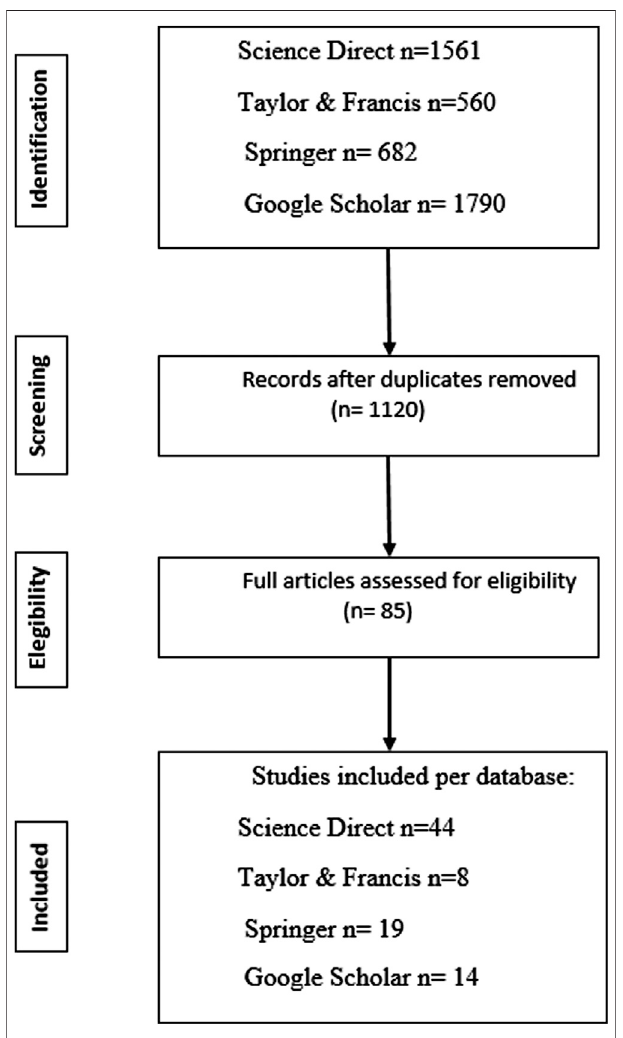
FIGURE 1 | PRISMA Flowchart showing the selection of the research articlesthat metourselection criteria: Thebacterial species studied arepart of a plant microbiome, exhibit plant growth-promoting characteristics, bacterial resistance to the metals (arsenic, cadmium, and lead) is expressed in terms of the Minimum Inhibitory Concentration (MIC) and metal resistance is related to biochemical or molecular mechanisms.